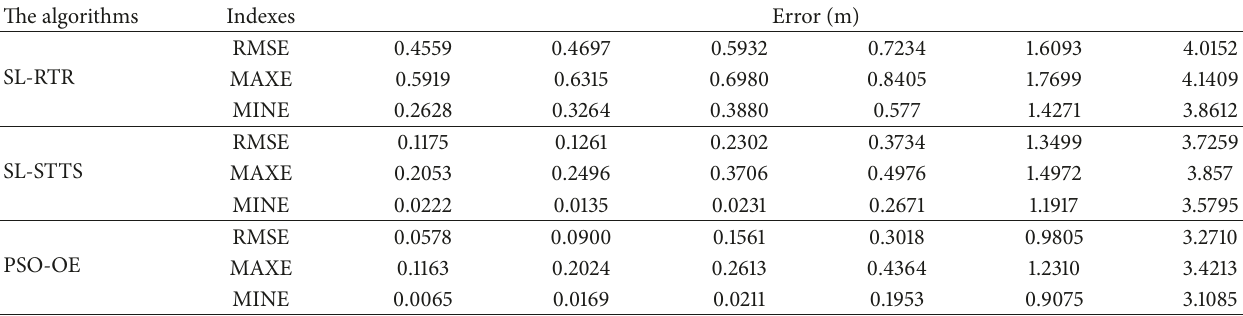
Table 5: The performance indexes of the localization task by different transponder location noise.